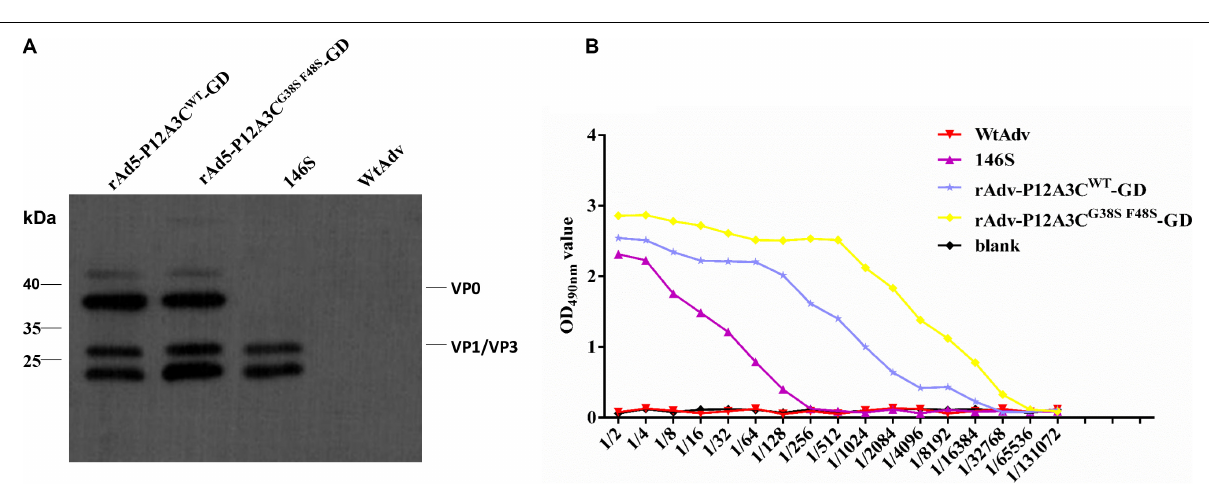
IgA antibody responses than WtAdv ( P < 0.01) at 14 dpi, and even higher IgA antibody responses were induced at 28